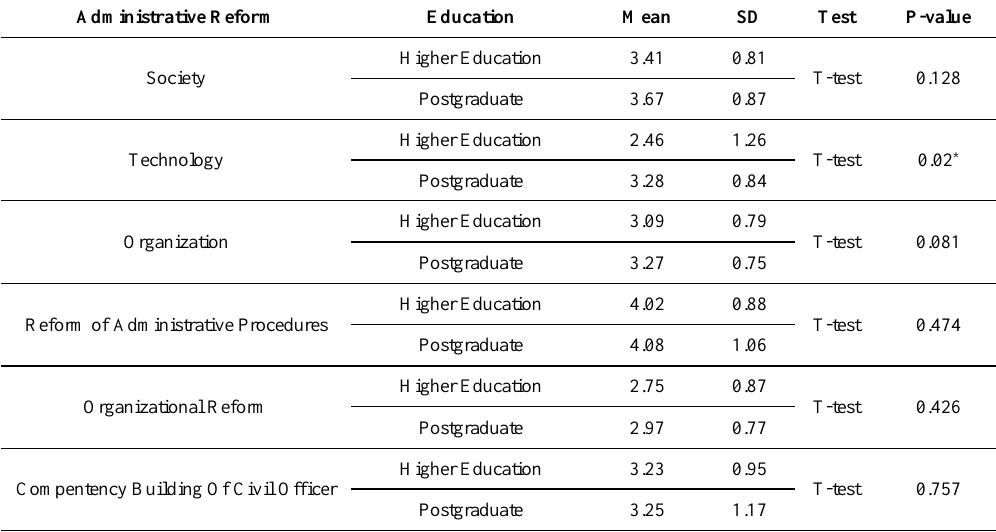
Table 6. Digital transformation and administrative reform under education